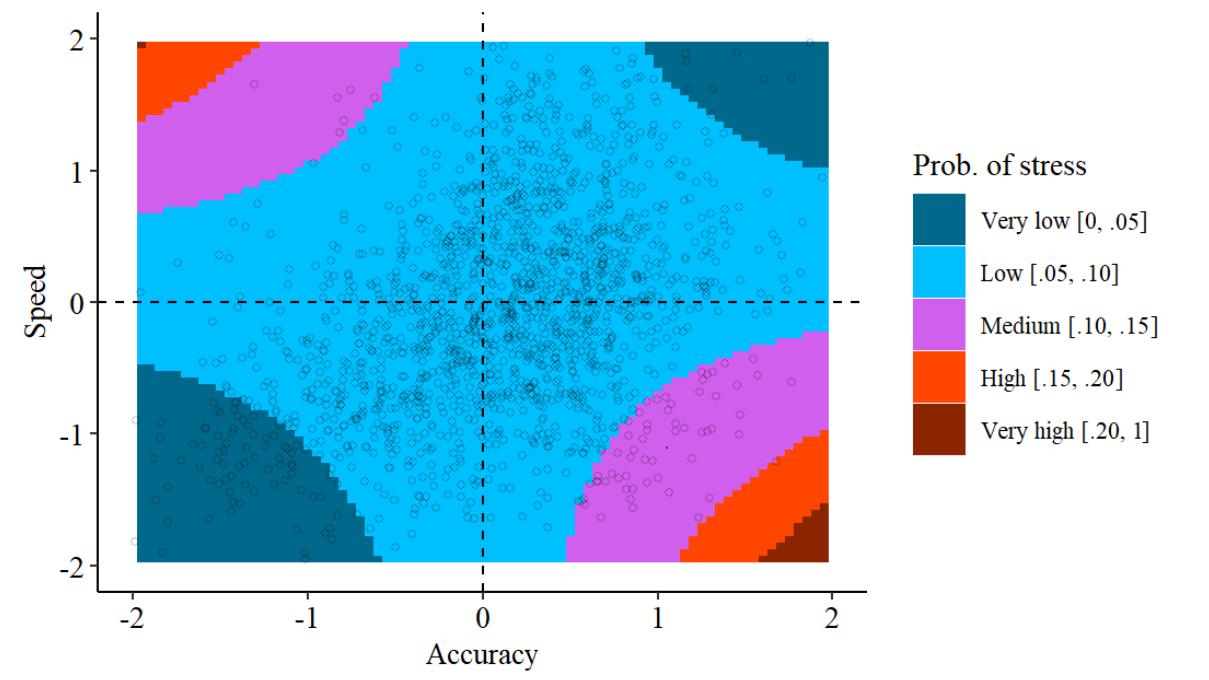
Figure 4. Probability (Prob.) of perceived stress based on mouse speed and accuracy. Shown is the partial dependence of stress on mouse speed and accuracy in the range of −2 SD to +2 SD. Red areas indicate high levels and blue areas indicate low levels of